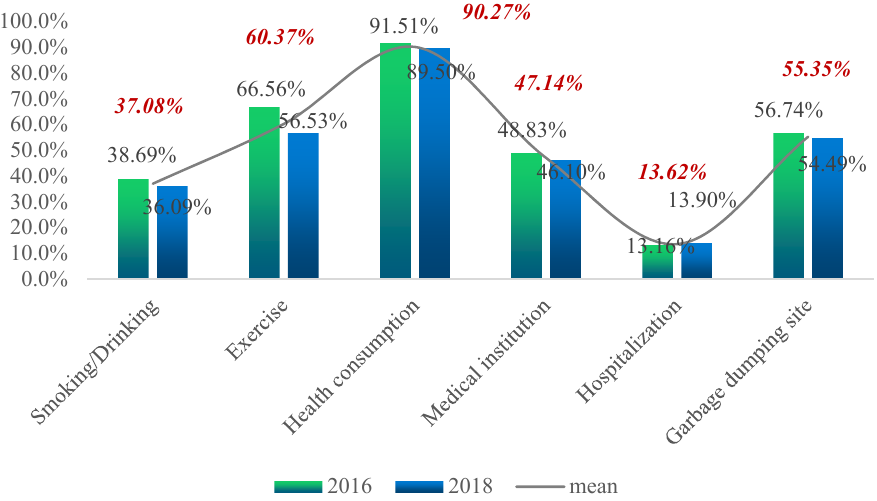
Figure 3. Proportion of the poor for each indicator of the individual health literacy and behavioral dimension.